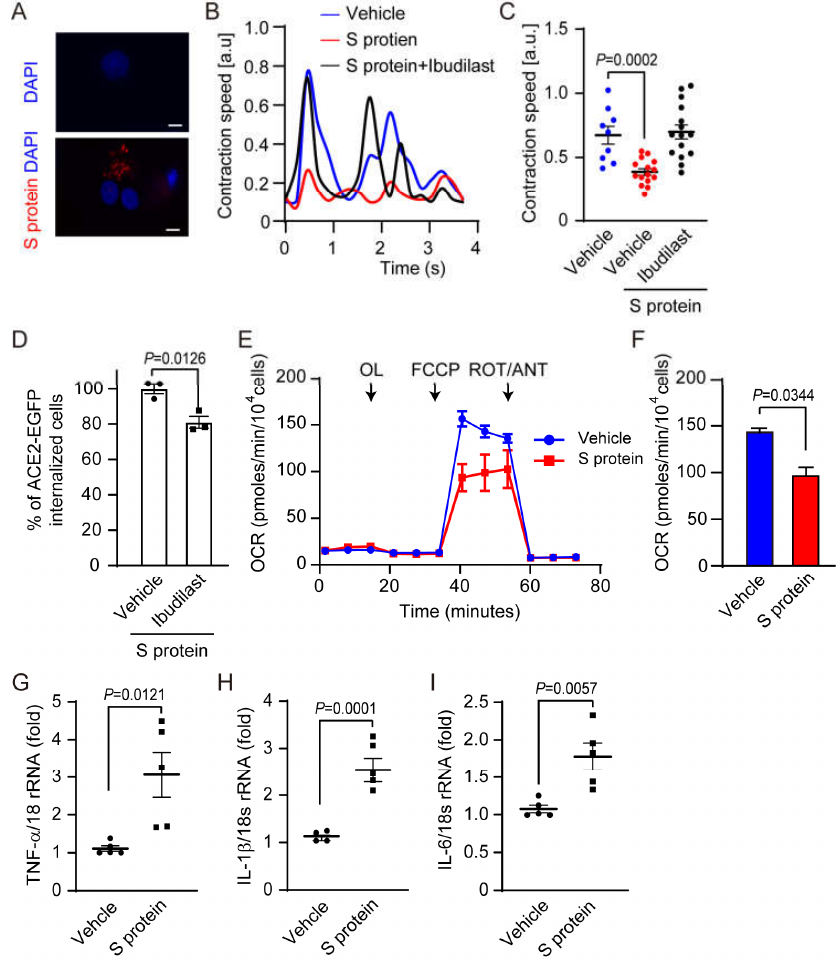
Figure 1. Exposure of NRCMs to SARS-CoV-2 pseudovirus causes contractile and metabolic dys- functions and cytokine productions. ( A ) Representative images of internalization of HiLyte Fluor 555-labeled S protein (red) in NRCMs co-stained with DAPI (blue). Scale bars = 10 µ m. ( B ) Sponta- neous contraction speed of NRCMs by exposure to S protein (50 nM) for 3 h with (black) or without (red) ibudilast, or exposure to vehicle (blue). ( C ) Peak contraction speeds of NRCMs treated with (black) or without (red) ibudilast (100 nM) 1 h before S protein (50 nM) exposure for 3 h. Those of vehicle exposed NRCMs (control) are shown in blue. ( D ) ACE2-EGFP internalization treated with ibudilast (100 nM) 1 h before S protein for 3 h in HEK293T cells. ( E ) Oxygen consumption rate (OCR) of NRCMs stimulated with S protein (red) or PBS (blue) for 24 h. ( n = 3 independent experiments) OL: oligomycin; FCCP: carbonyl cyanide p-[trifluoromethoxy]-phenylhydrazone; ROT: Rotenone; ANT: antimycin. ( F ) Average maximal OCR in ( E ). ( G – I ) cytokine mRNA expressions in NRCMs treated with S protein for 3 h. All data are shown as mean ± SEM; n = 3–5. Significance was imparted using t -test and one-way ANOVA followed by Tukey’s comparison